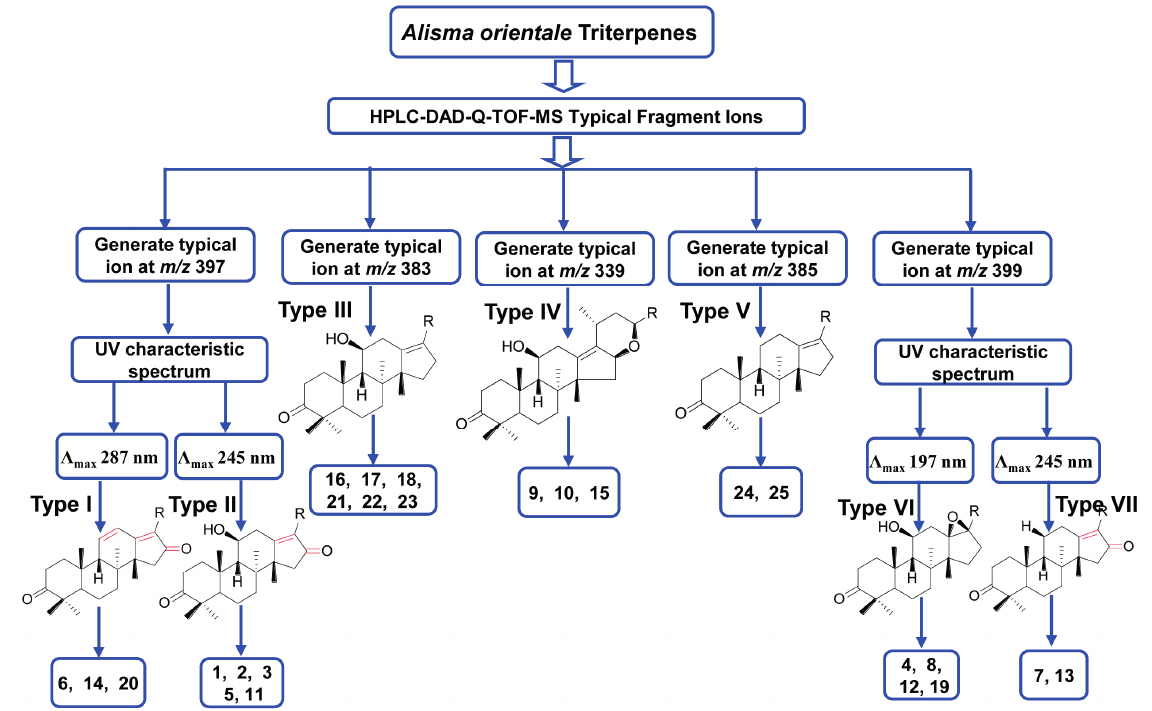
Figure 3. The classification of the 25 compounds based on their structural